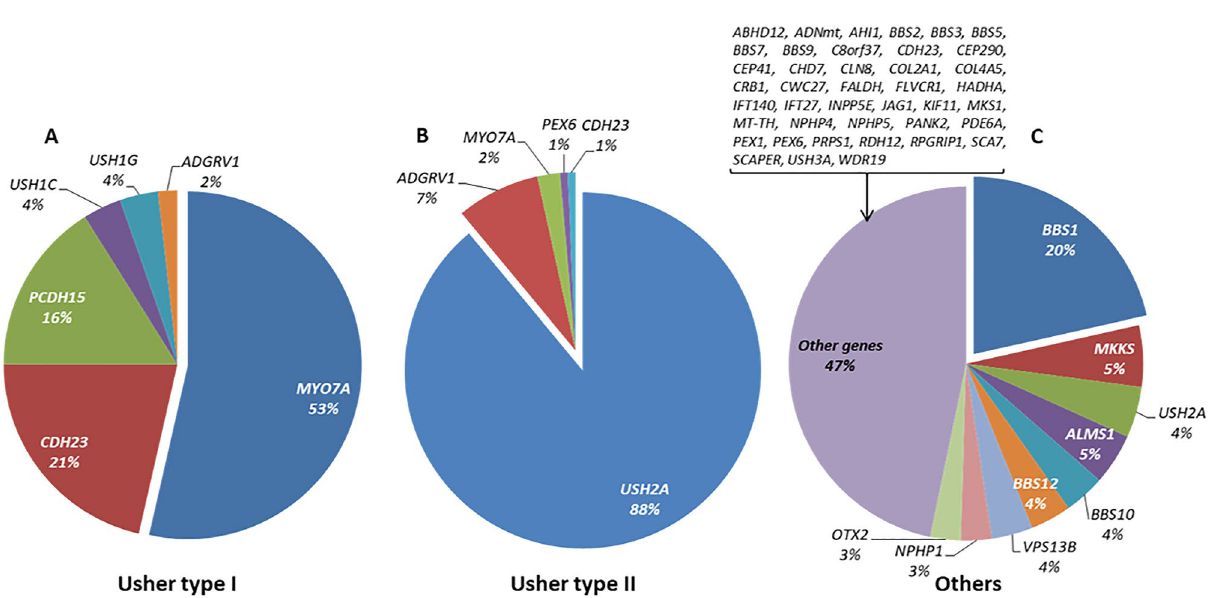
Figure 4. Classification of mutated genes in the genetically solved RP affected cases. Below each gene is given the percentage that each gene was mutated in the cohort. Total characterized families: AD-RP: 207; AR-RP: 666; XL-RP: 165.